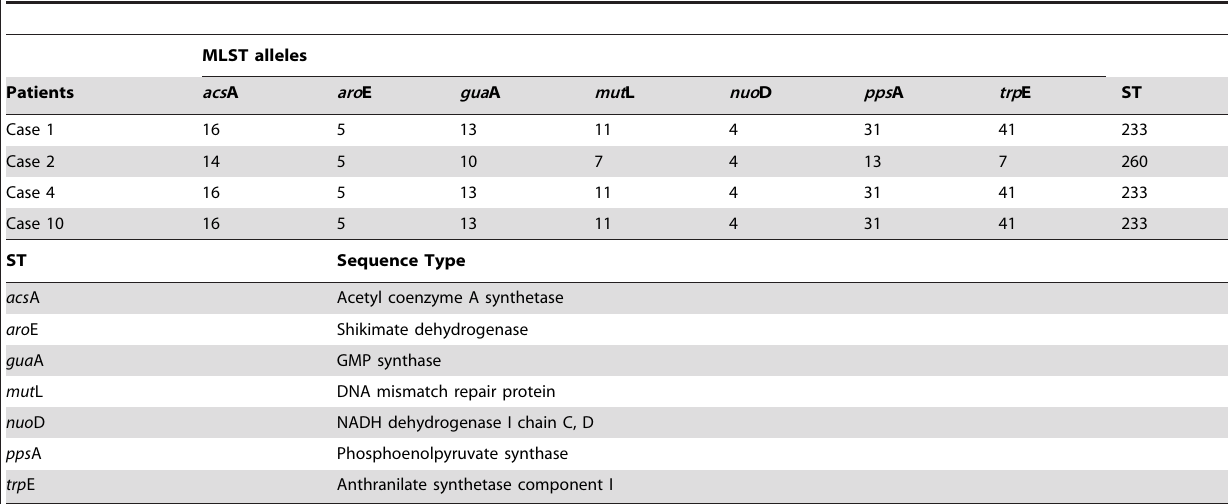
Table 2. Multi-locus sequence typing (MLST) allelic profiles and sequences for five selected Pseudomonas aeruginosa isolates as determined from the MLST database (http://pubmlst.org/paeruginosa/).